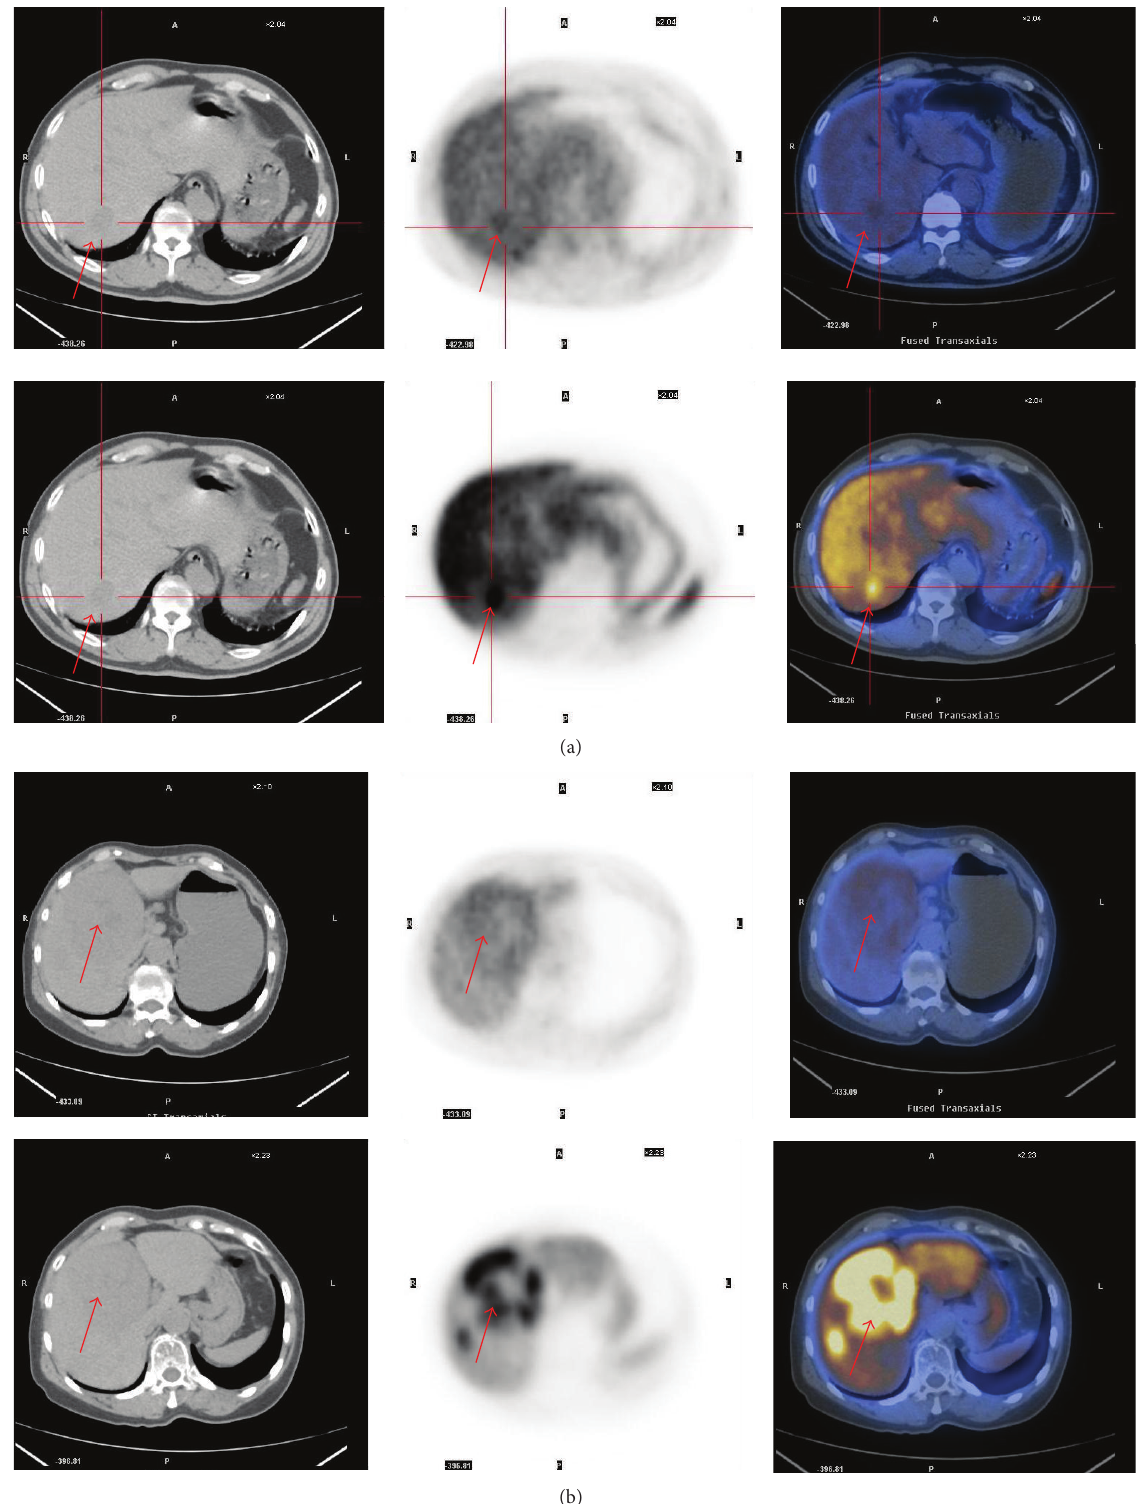
Figure 3: (a) 18 F-FDG PET/CT images showed that lesion in the right hepatic lobe was 18 F-FDG positive (SUV max : 2.4), and 11 C-CHO PET/CT images showed that the uptake of lesion was increased (SUV max : 10.7) (red arrows on a). (b) 18 F-FDG PET/CT image showed that lesion in the right hepatic lobe was 18 F-FDG negative; 11 C-CHO PET/CT image showed that the uptake of lesion was increased (SUV max : 12.8). These two cases in the right hepatic lobe were consistent with PHC (red arrows on